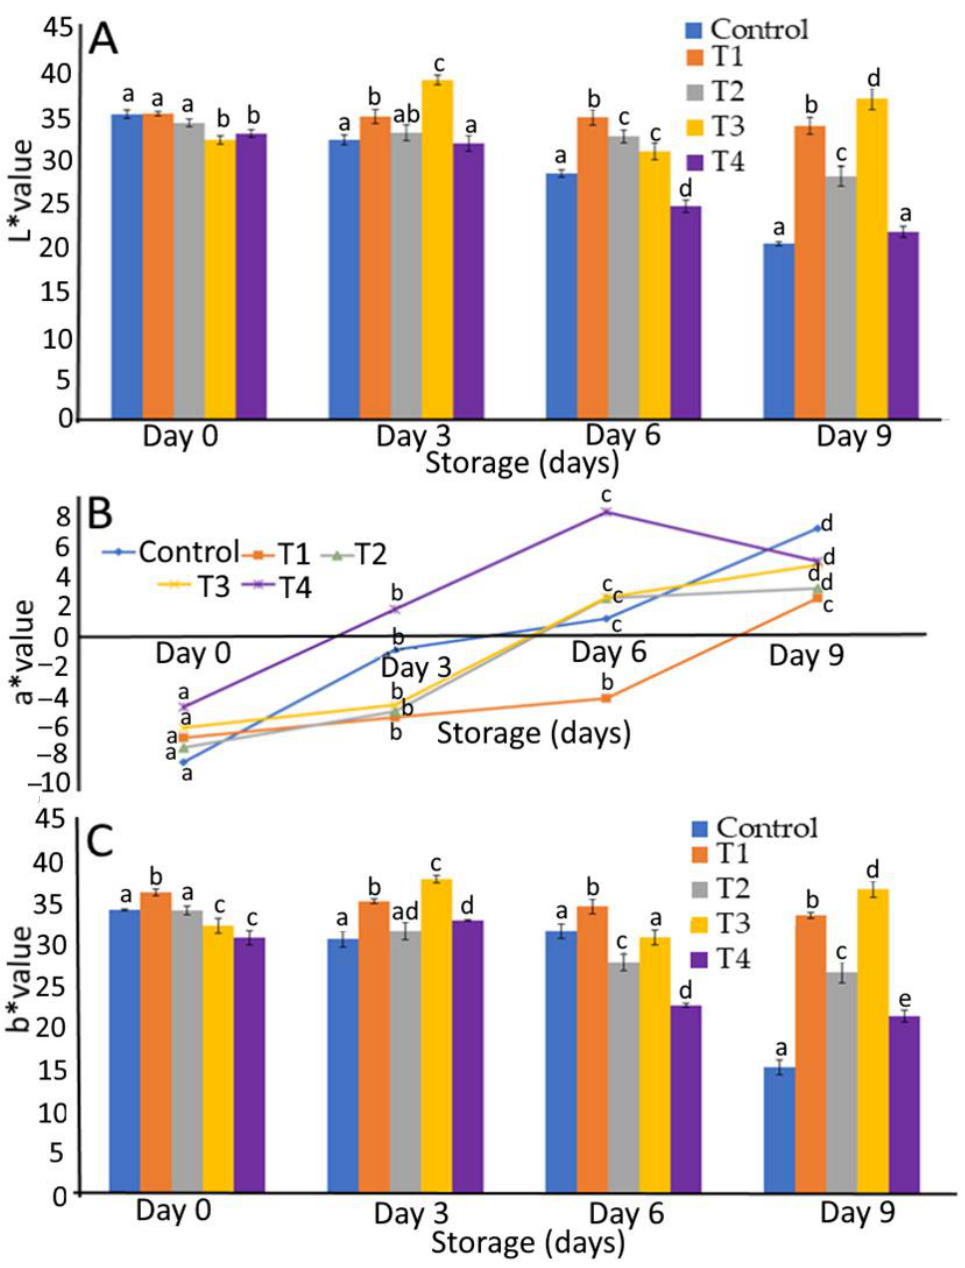
Figure 3. L* value ( A ), a* value ( B ), and ( C ) b* value of guava fruits at different stages. Different lowercase letters within the same group represent significant differences based on Tukey’s honest significance test ( p < 0.05). For sample codes, refer to Table 2.